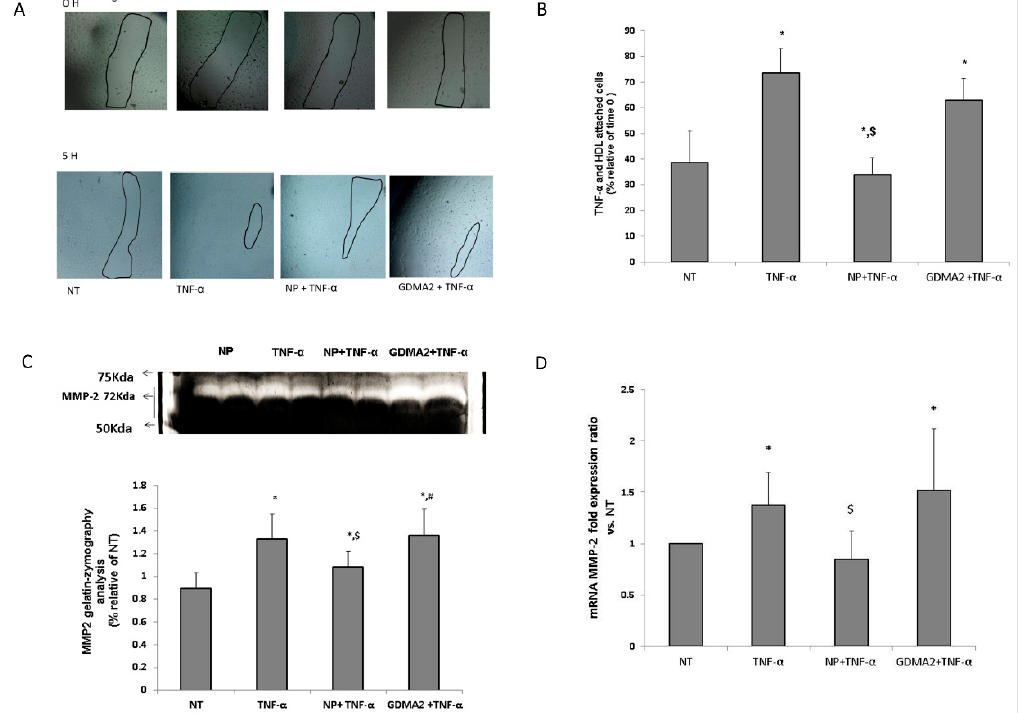
Figure 3. HDL and endothelial cell migration: ( A , B ) HDL-GDM (100 µ g / mL) and HDL-NP (100 µ g / mL) were added to cells for 1 h and stimulated with TNF- α (1 ng / mL) for an additional 4 h, marked in figure as NT (nontreatment), NP + TNF- α and GDM + TNF- α . Results were normalized to time 0. * p < 0.05 compared to NT, $ p < 0.05 compared to TNF- α treatment. ( C ) After 5 h, supernatants were collected and MMPs activity was measured by gelatin zymography, relative analysis of MMP-2 results were normalized to NT. ( D ) MMP-2 mRNA fold expression ratio vs. NT. * p < 0.05 compared to NT, $ p < 0.05 compared to TNF- α treatment, # p < 0.05 compared to NP + TNF- α treatment. Representative figures of 4 independent experiments (HUVEC from 4 different donors) including 3 technical repeats for each experiment. HDLs from different donors were used for the migration assay.